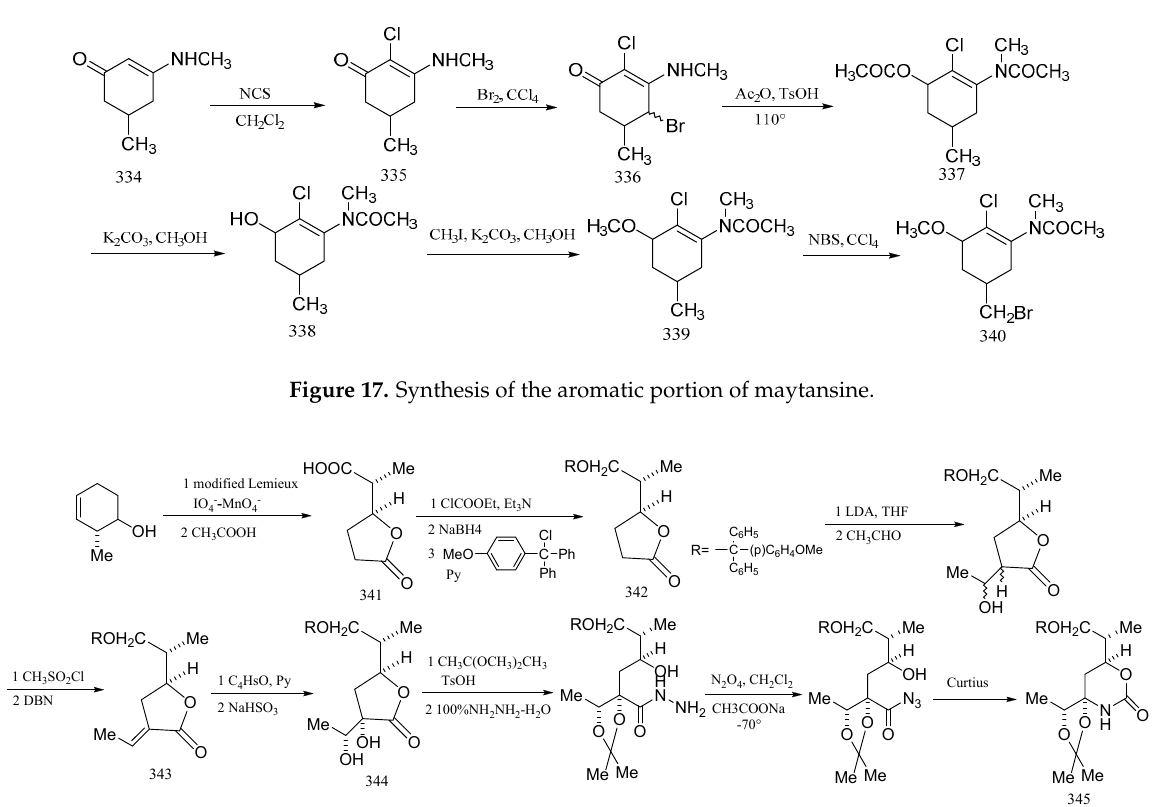
Figure 18. Compounds synthesized from the cyclic carbamate unit of maytansine.